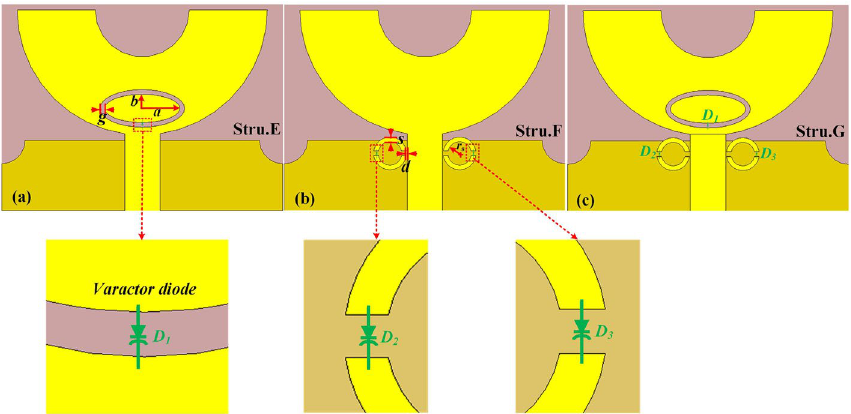
Figure 3. ( a ) The schematic diagram of the proposed UWB loaded with varactor diode with tunable dual band- notched characteristics where there named as ( a ) Stru.E, ( b ) Stru.F and ( c ) Stru.G.